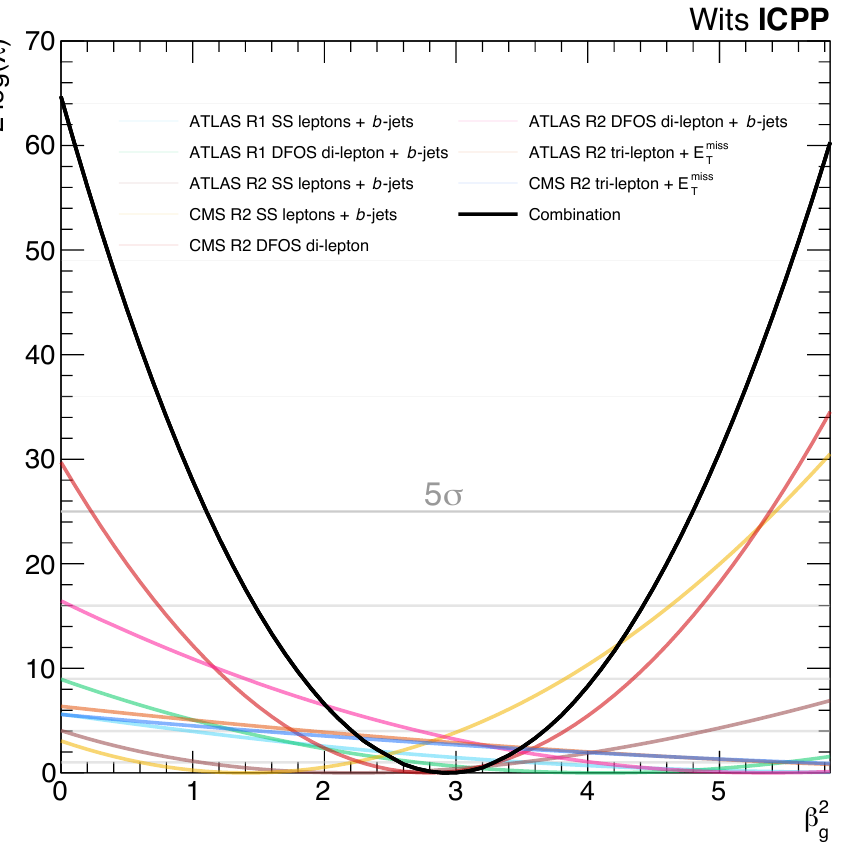
Figure 8 . The (negative 2 times the logarithm of the) pro(cid:12)le likelihood ratios for each of the indi- vidual (cid:12)t results considered in this article, overlaid with that of their combination. The signi(cid:12)cance of a result is calculated as the square root of the point which intersects the y -axis (that is, the SM-only hypothesis where (cid:12) 2 = g